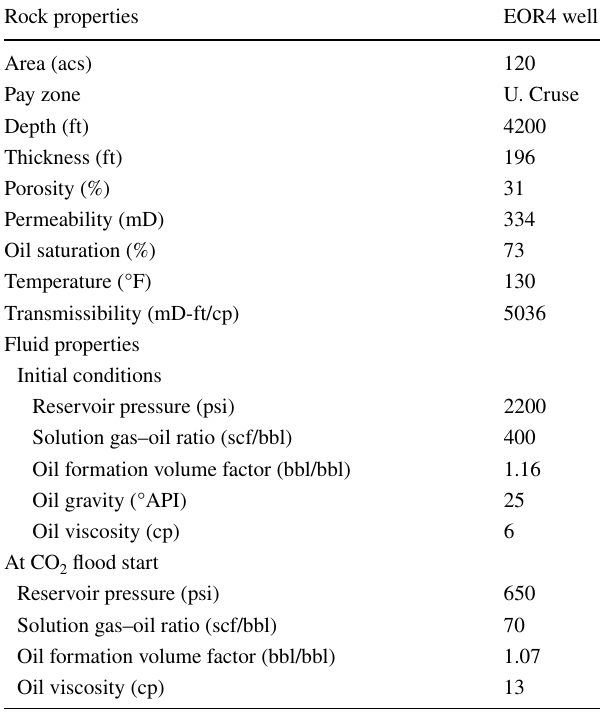
Table 2 Reservoir data for EOR 4 well-forest